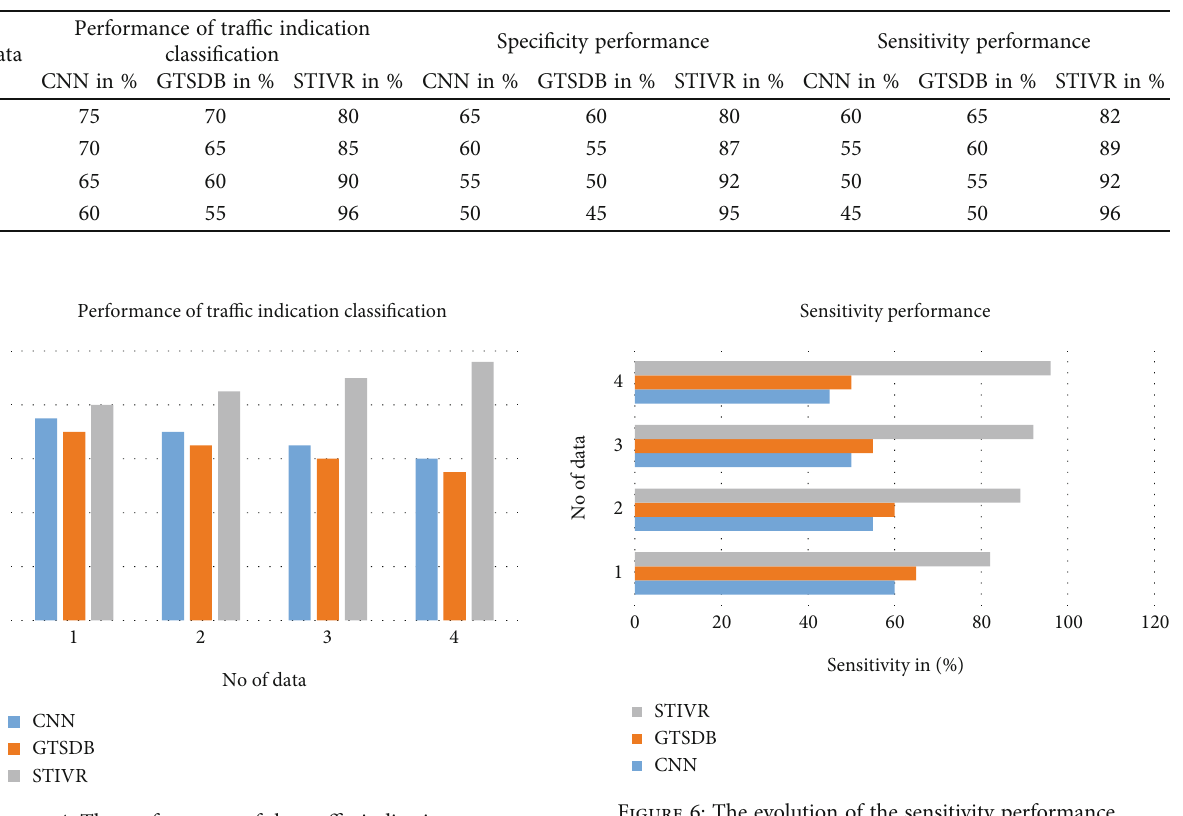
Figure 4: The performance of the tra ffi c indication.